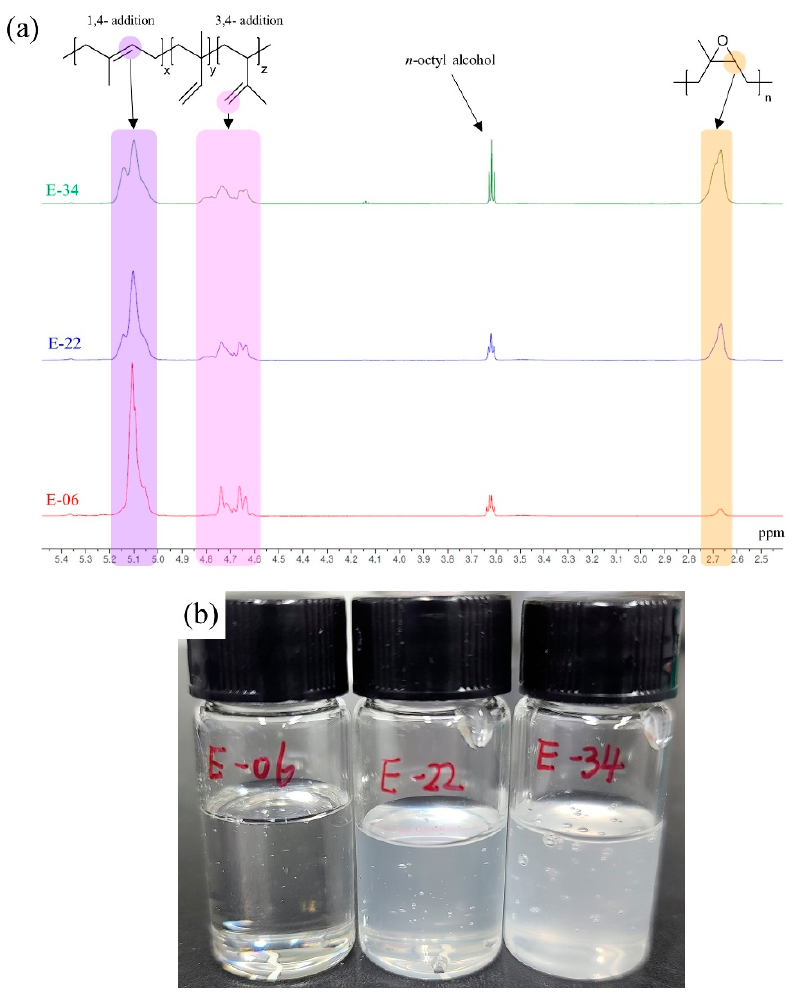
Figure 1. Synthesized E-LqIRs: ( a ) 1 H NMR spectra, and ( b ) photographic image. Table 3. Characteristics of the LqIR and